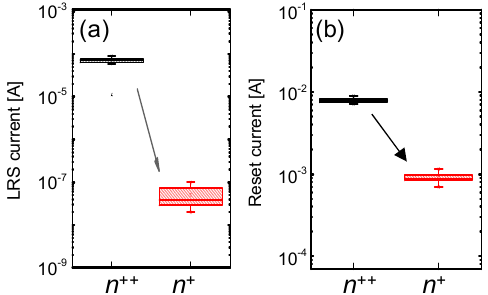
Figure 6. Statistical distribution of ( a ) the LRS current and ( b ) the reset current for Ni/SiN x /n + Si device and Ni/SiN x /n ++ Si devices.